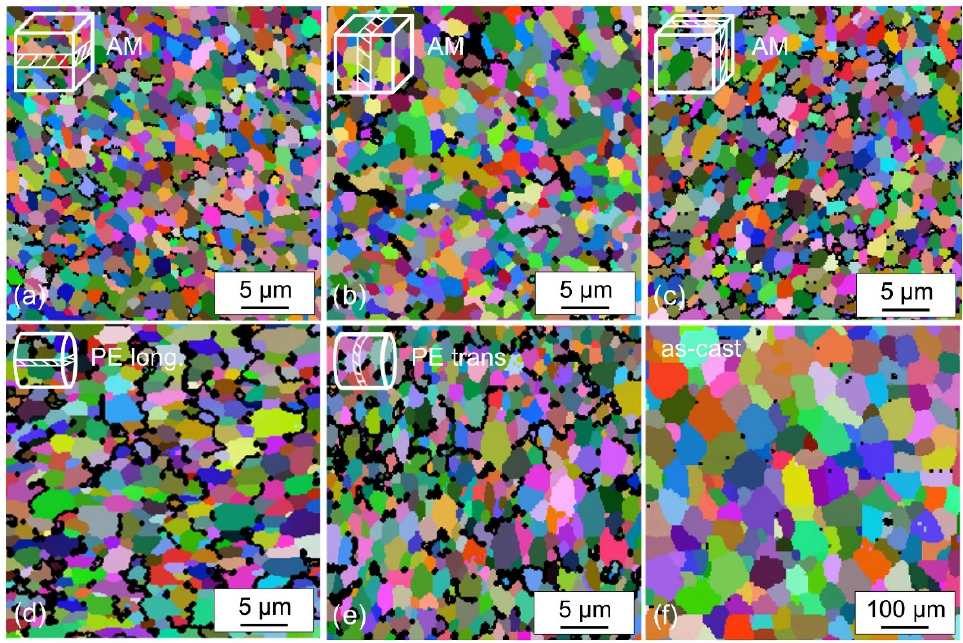
Figure 7. Electron backscatter diffraction of ( a – c ) selective laser melting, ( d , e ) of powder extruded, ( f ) of as-cast material. Reprinted with permission from ref. [58]. Copyright 2019 Elsevier. The multiple remelting in the SLM process makes the microstructure change in dif- ferent height directions, which is attributed to the different heat treatment, conduction, convection and radiation conditions between different layers. After repeated remelting, the cooling rate decreases relatively, which coarsens the grains in the remelted part. The microstructure is different due to the difference of heat affected zone between the edge and center of molten pool. In the preparation of AZ91D alloy by SLM, the grains in the scanning track area are smaller than those in the overlapping area, which is caused by the repeated remelting of the grains at the edge of the molten pool, the reduction of the cooling rate, and the existence of temperature gradient difference. Figure 8 shows the distribution of molten pool under the optical microscope of AZ91D sample under the bulk energy density of 166.7 J/mm 3 , which obeys the Gaussian distribution of laser energy. The molten pool with elliptical bottom is arranged layer by layer, which is the inherent layered feature of SLM technology. The molten pool is closely stacked, forming a good metallurgical bond between two adjacent layers. [47] In addition, due to the temperature gradient difference between the edge and center of the molten pool, the transformation from columnar crystal to equiaxed crystal may occur from the edge of the molten pool to the center. Columnar α -Mg grains occupy the edge area of the molten pool, while the α -Mg grains in the center area of the molten pool show equiaxed crystal state.